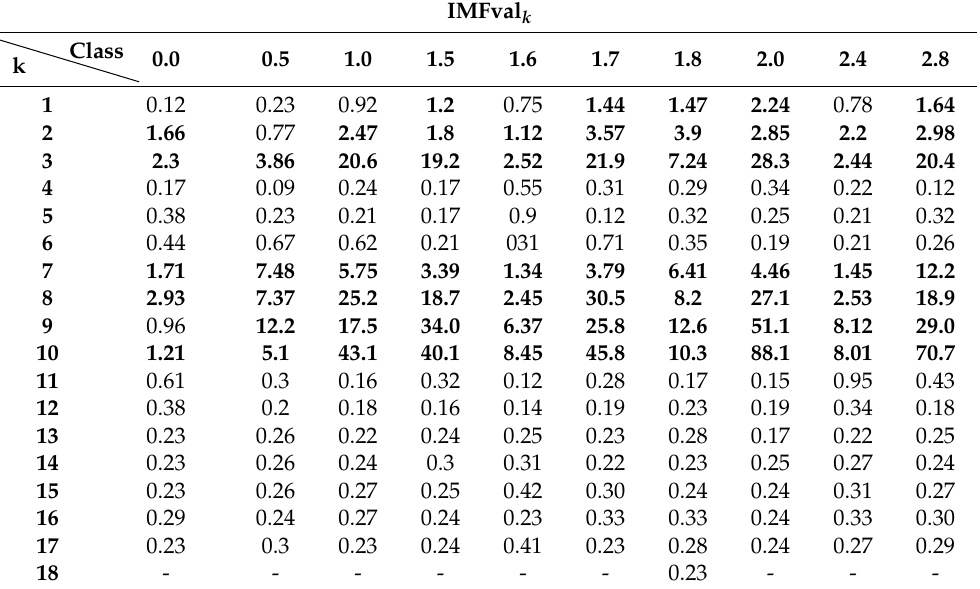
Table 3. The objective values of the proposed IMF selection metric calculated for all the extracted components for each signal class. The values highlighted with bold font correspond to the selected valuable IMFs.